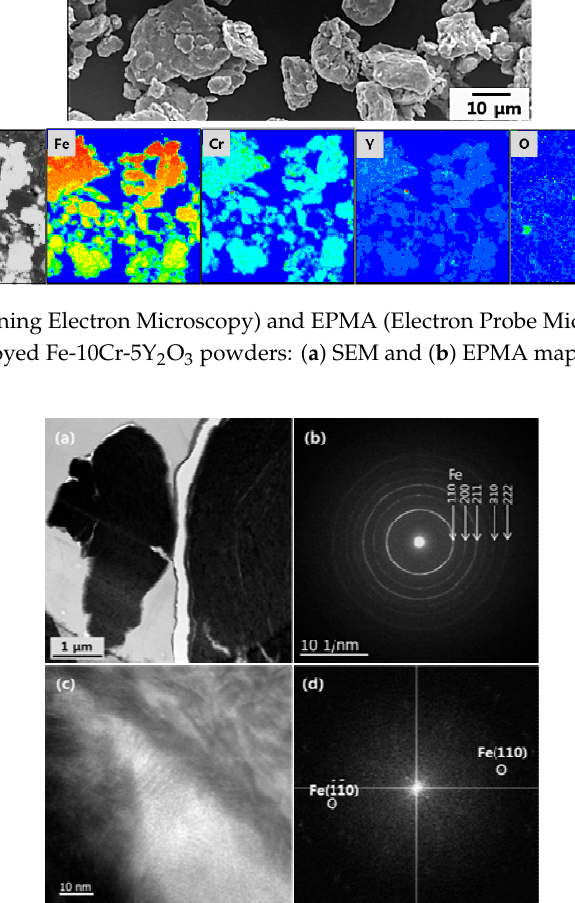
Figure 3. TEM analysis results of mechanically alloyed Fe-10Cr-5Y 2 O 3 powders after heat treatment at 90 °C: ( a ) TEM image, ( b ) SAD pattern, ( c ) HRTEM image, and ( d ) FFT pattern. 3.2. Microstructural Evolution of Oxide Particles Figure 4 shows the microstructural observation of temperature-dependent phenomena in mechanically alloyed Fe-10Cr-5Y 2 O 3 powder up to 900 °C. A nano-crystalline textured structure was observed in the mechanically alloyed powder before heating (Figure 4a). It was revealed that the microstructure of mechanically alloyed powder was a nano-crystalline textured structure. There were no significant changes to the microstructure until the temperature reached up to 600 °C (Figure 4b). A further increase in temperature caused significant changes in the microstructure. Upon heating above 700 °C (Figure 4c), grain growth of the crystalline phase was detected. During heating from 800 °C to 900 °C (Figure 4d,e), considerable grain growth of nano-sized oxide particles occurred. Consequently, the nano-sized particle grew to a few microns in diameter after heating at 900 °C, as shown in Figure 4f. Based on these results, the nano-sized grain and tangled dislocations were initially produced by the MA process. It may have caused the transfer of mechanical energy to the powder particles and led to the introduction of strain into the powders through the generation